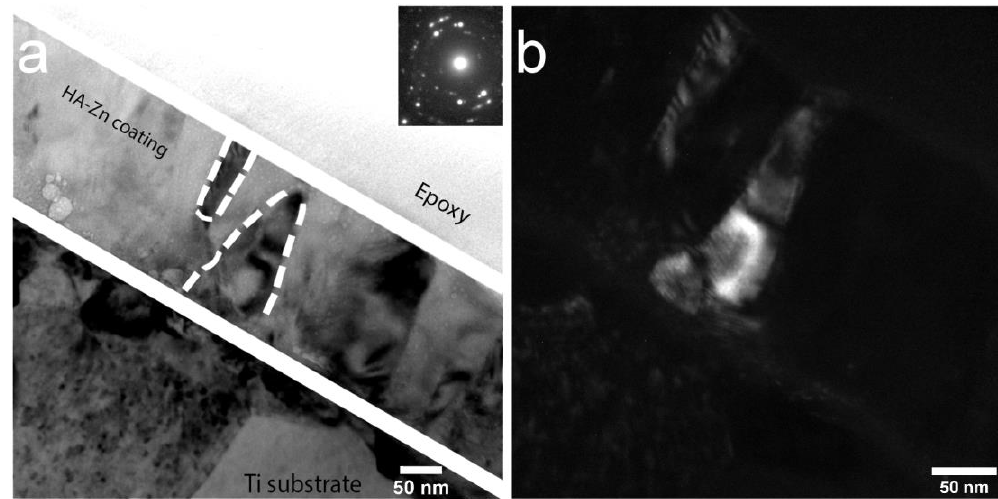
Figure 12. TEM image of the cross-section of Zn-HA coating on Ti deposited at the substrate temperature of 400 °C BF, the inset shows the corresponding electron diffraction pattern ( a ) and DF ( b